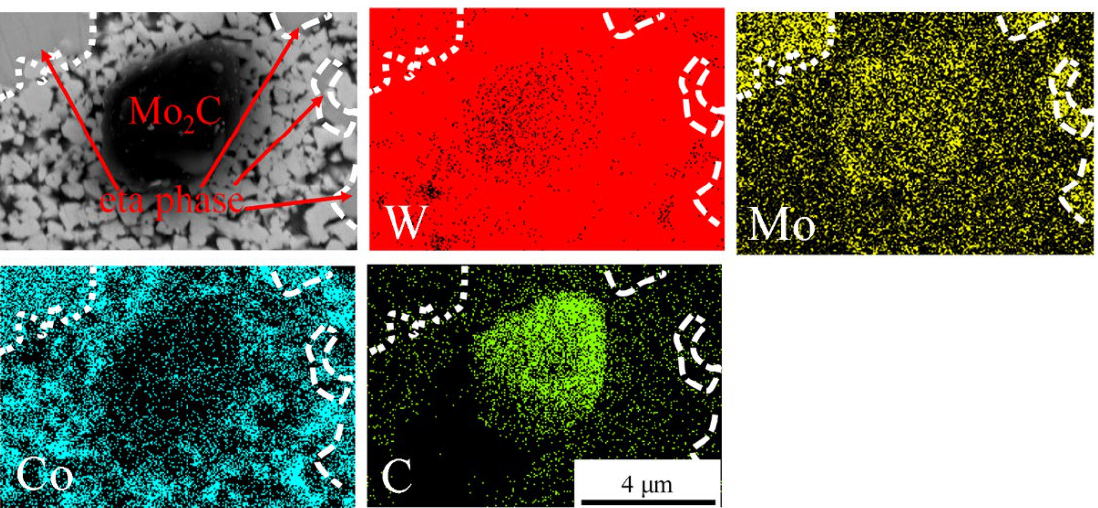
8 of 13 Figure 7. Mapping of elements distribution of the 2.5Mo-5.0C sample. ( a ) Co phase and ( b ) eta phase. Figure 8. Elements distribution of ( a ) Co phase and ( b ) eta phase in the 2.5Mo-5.0C sample. It is worth noting that some large black particles are observed in Figure 5g. Its com- position was analyzed by EDS in Figure 9. The results show that this large particle is en- riched with Mo and C. According to the X-ray analysis in Figure 2, this large black particle should be the Mo 2 C. It can be seen from Figure 5 that such large spherical particles are a low-frequency occurrence. Guo [7] observed that a small-sized Mo 2 C phase forms by the reaction of Mo and C at about 900 °C during the sintering process of WC-6Co alloys. Fig- ure 9 also indicates that a large amount of Mo is enriched in the eta phase in the 2.5Mo- 5.75C sample, which is consistent with the observation results of the eta phase of the 2.5Mo-5.0C sample as shown in Figures 7 and 8. Figure 10 compares the Mo 3d 3/2 and Mo 3d 5/2 XPS spectra of 2.5Mo-5.0C and 2.5Mo- 6.1C samples. The main peak of the 2.5Mo-5.0C sample is characterized by Mo 3d 3/2 and Mo 3d 5/2 features at 228.43 and 232.56 eV, while the main peak of 2.5Mo-6.1C sample is